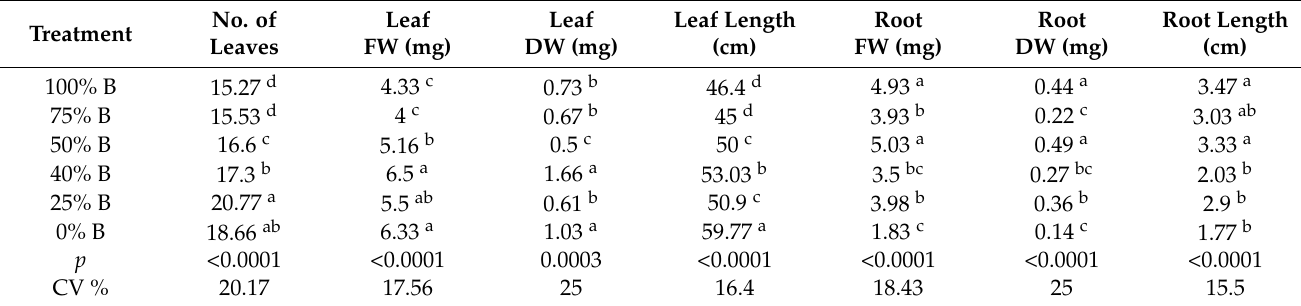
Table 3. Leaf and root properties of saffron plants grown under different ratios of Blue (B) to Red (R) light in the overall spectral composition, including 100% B, 75% B, 50% B, 40% B, 25% B, 0% B (see the spectrum in Figure 1), with 150 ± 10 µ mol m − 2 s − 1 PPFD. Means within a column followed by the same letters are not significantly different at p ≤ 0.01 according to Duncan’s multiple range test. CV % indicates the percentages of coefficient of variation among the treatments. No. Treatment